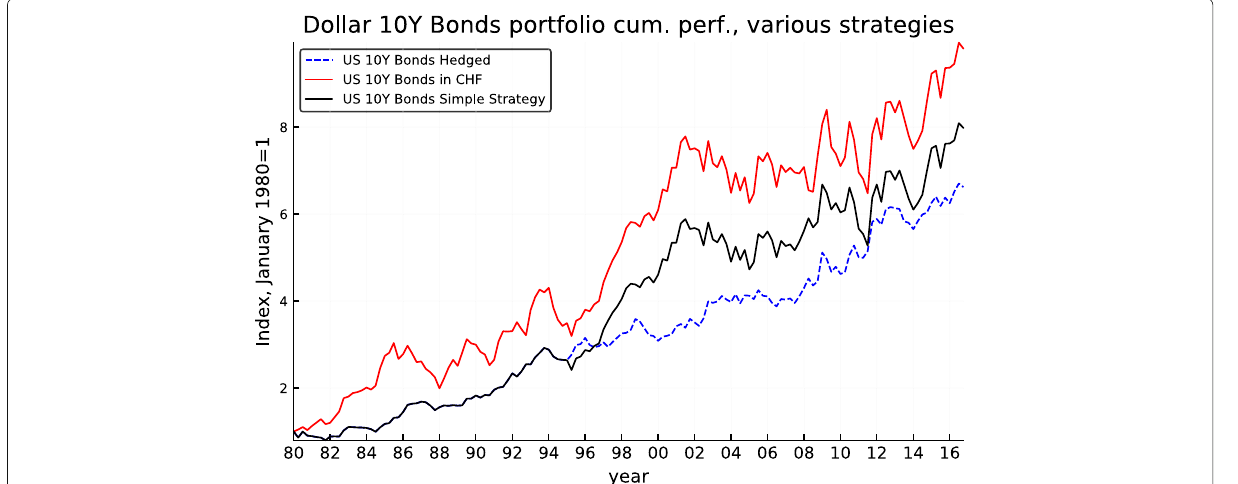
Fig. 7 Dollar 10-year bond cumulative performance: unhedged, hedged, and simple strategy